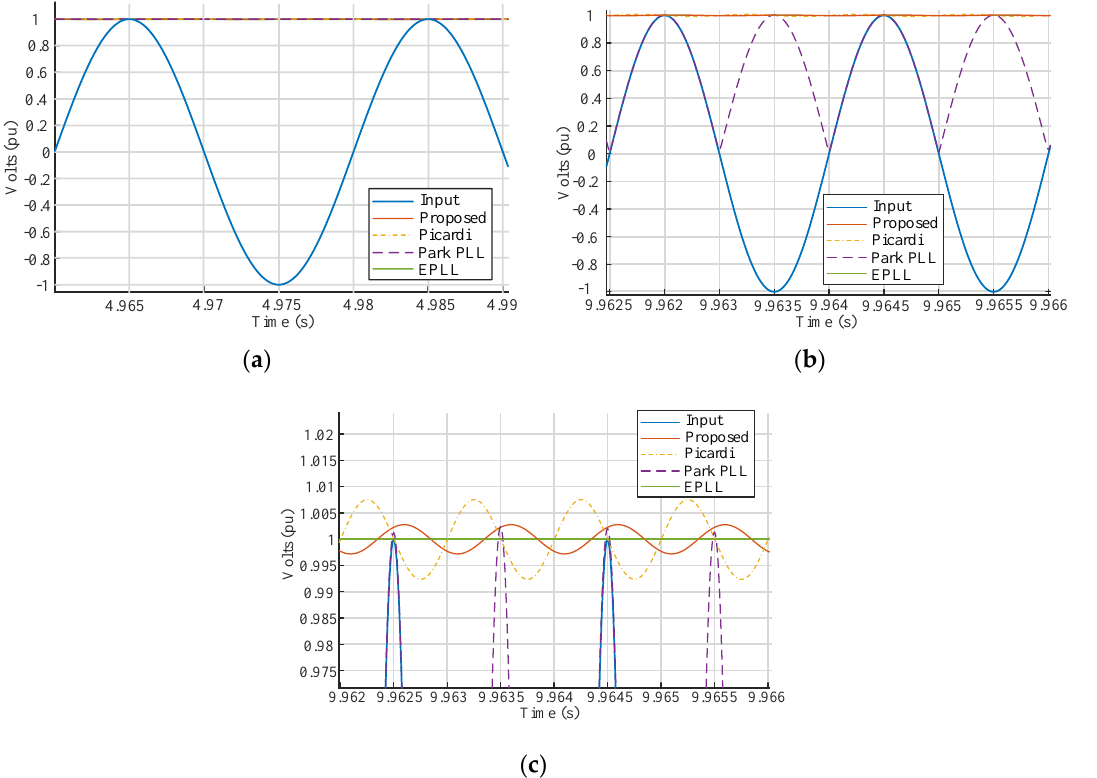
Figure 13. Comparison of amplitude detection techniques for a 1 pu input of ( a ) 50 Hz; ( b ) 500 Hz; ( c ) zoomed 500 Hz.